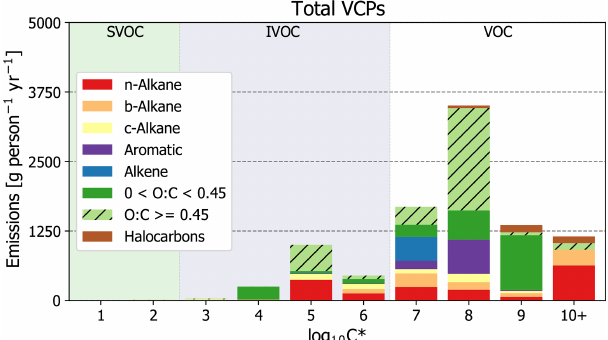
Figure 2. Sector-wide volatility distribution of emissions by com- pound